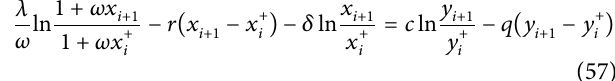
, 휏 4 = 0.1801 , 푟 = 0.23